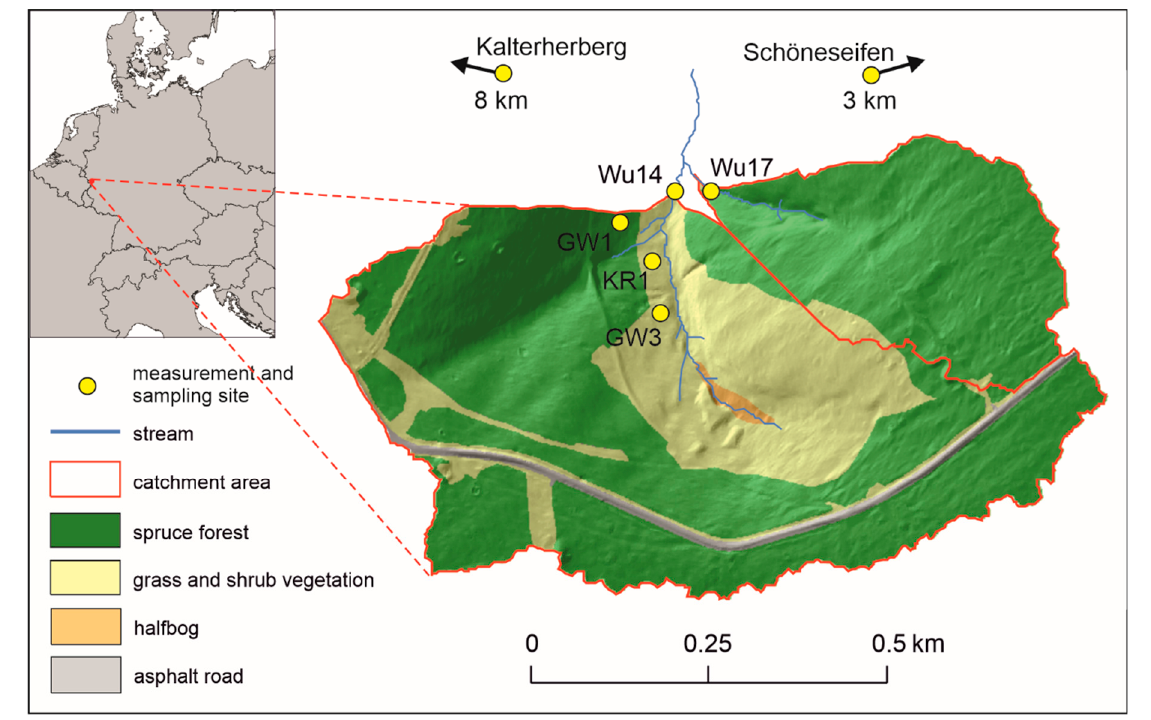
Figure 1. Land cover map of the Wüstebach experimental catchment (as of 2020) and the location of the measurement and sampling sites used for this study.